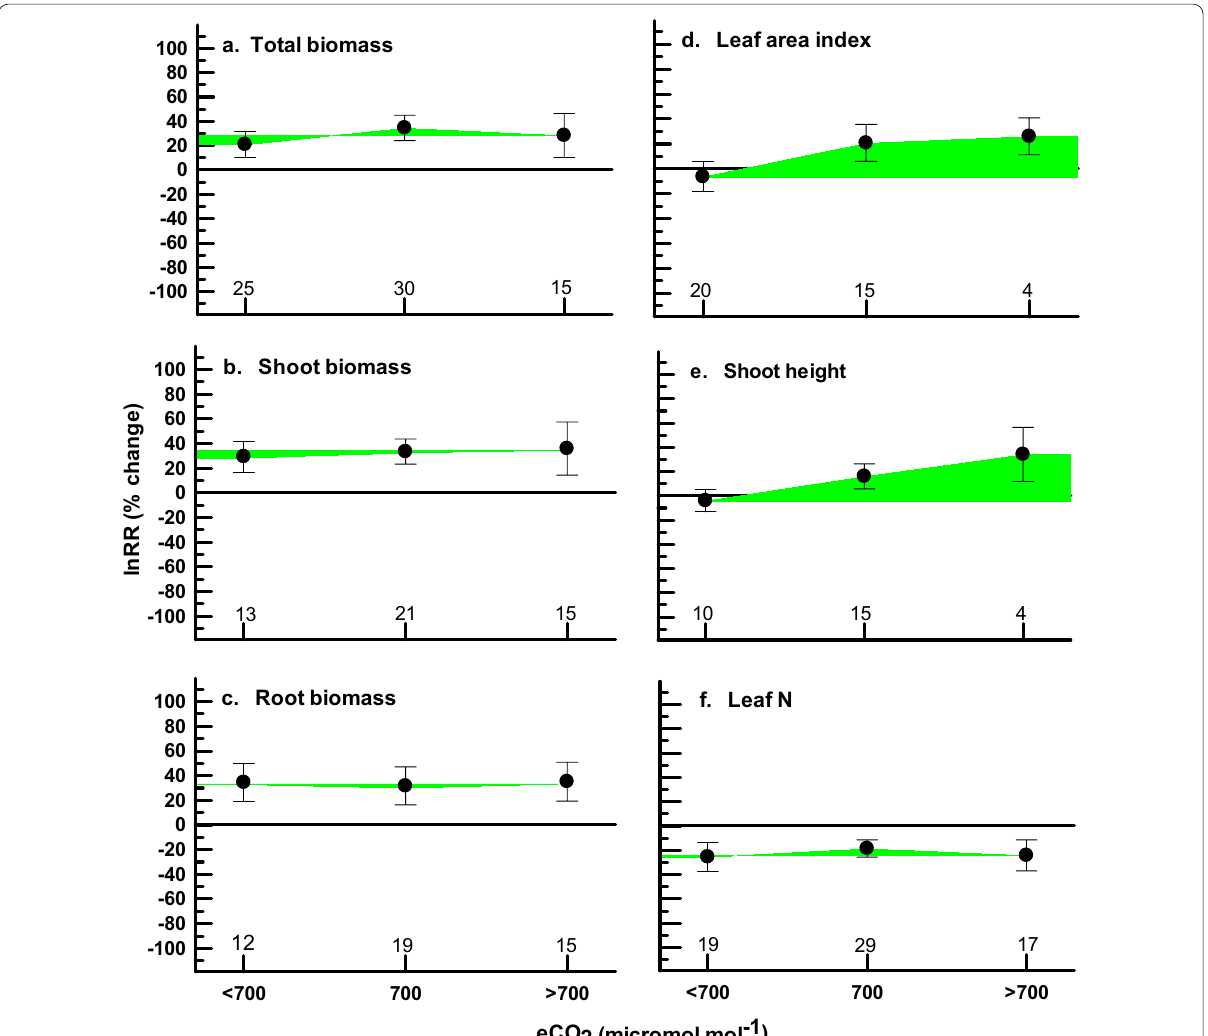
Fig. 1 Percentage change ( 95% CI) in biomass ( a – c ), leaf area index ( d ), growth ( e ) and leaf N ( f ) of woody plants grown at eCO 2 . The whiskers ± denote 95% CI and the circles denote mean percentage change (MPC) between aCO 2 and eCO 2 . The numbers above the major ticks of the X -axis denote number of observations. The area fill ( ) shows the trends and the magnitude of differences between the eCO 2 concentrations. The wider the area the bigger the difference between